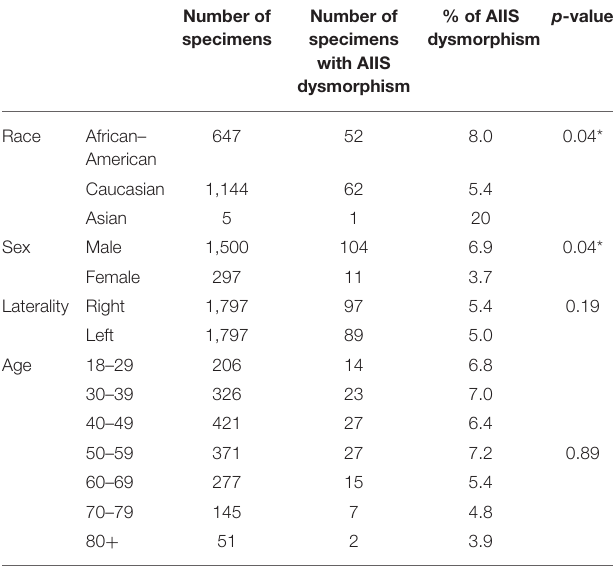
TABLE 2 | Analysis of anterior inferior iliac spine dysmorphism.